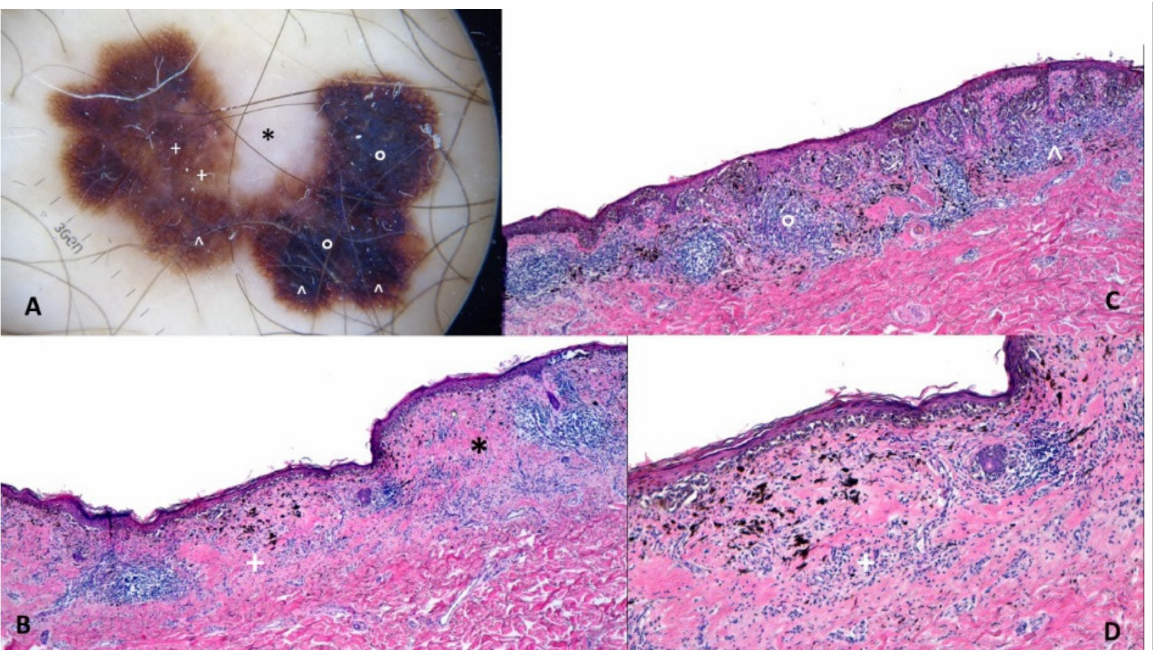
Figure 1. Superficial spreading melanoma (T1a, Breslow 0.5 mm) on the abdomen of an 82-y old man. This de novo slow-growing melanoma shows on polarized contact dermoscopy (Dermalite ProHR ® , 3Gen, San Juan Capistrano, CA USA) an asymmetric polychromatic multicomponent pattern with atypical pigment network (Panel A : labeled ˆ), white regression (Panel A : labeled *), structureless blue pigmentation (Panel A : labeled ◦ ) and structureless brown-blue bichromatic areas (Panel A : labeled +). The atypical network correlates with the hyperpigmented rete ridges with atypical melanocytes in single units and irregular nests mostly arranged at the DEJ (Panel C : labeled ˆ); the presence of a heavy lymphohistiocytic infiltrate with melanophages and acanthosis of the epidermis and heavily pigmented atypical nest and melanocytes in the epidermis are responsible for the structureless blue pigmentation (Panel C : labeled ◦ ). Panel B shows in the dermis fibrosis with a lymphohistiocytic infiltrate that correlates with the area of regression (Panel B : labeled *) while the atypical melanocytes in single units and irregular nests mostly arranged at the DEJ and the melanophages in the dermis correlate with structureless bichromatic brown-blue areas (Panel B , D : labeled +). (original magnification: Panel B , C : HE, 40 × ; Panel D : HE, 100 ×